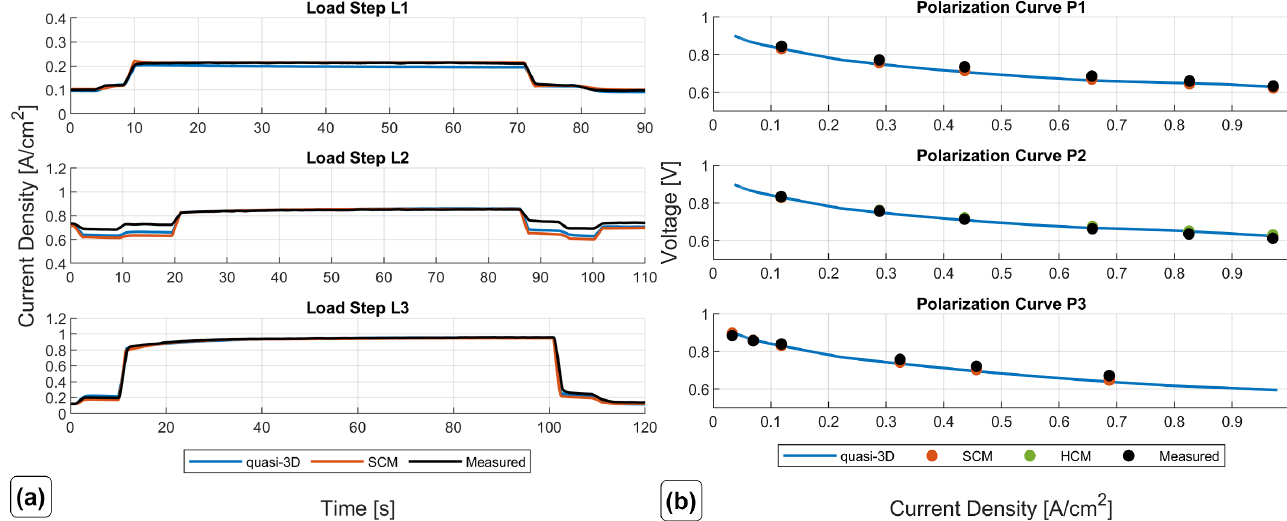
Figure 6. Comparison of simulated load steps and polarization curves. SCM results with updated parameters for the SCM model (DVS8 CFD row in Table 6). ( a ) Load steps. Averaged relative error: quasi-3D = 4.1%, SCM = 5.0%. ( b ) Polarization curves. Averaged relative error: quasi-3D = 2.0%, SCM = 1.5%. Polarization curve P2 was simulated with the HCM to show the good agreement with this model as well. The averaged relative error was